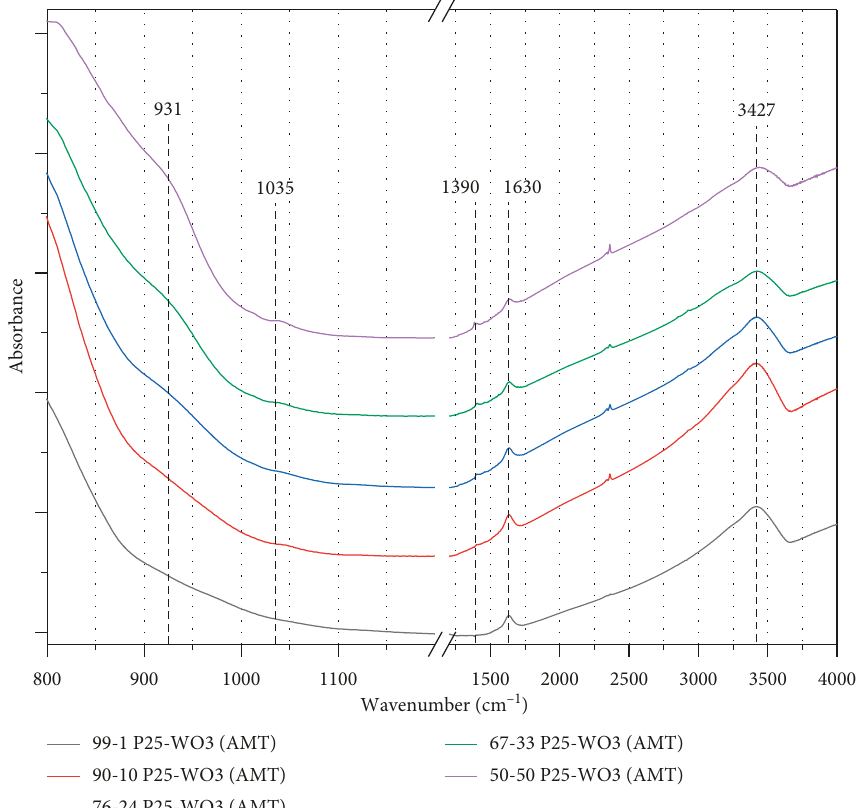
Figure 4: Infrared spectra of the prepared WO